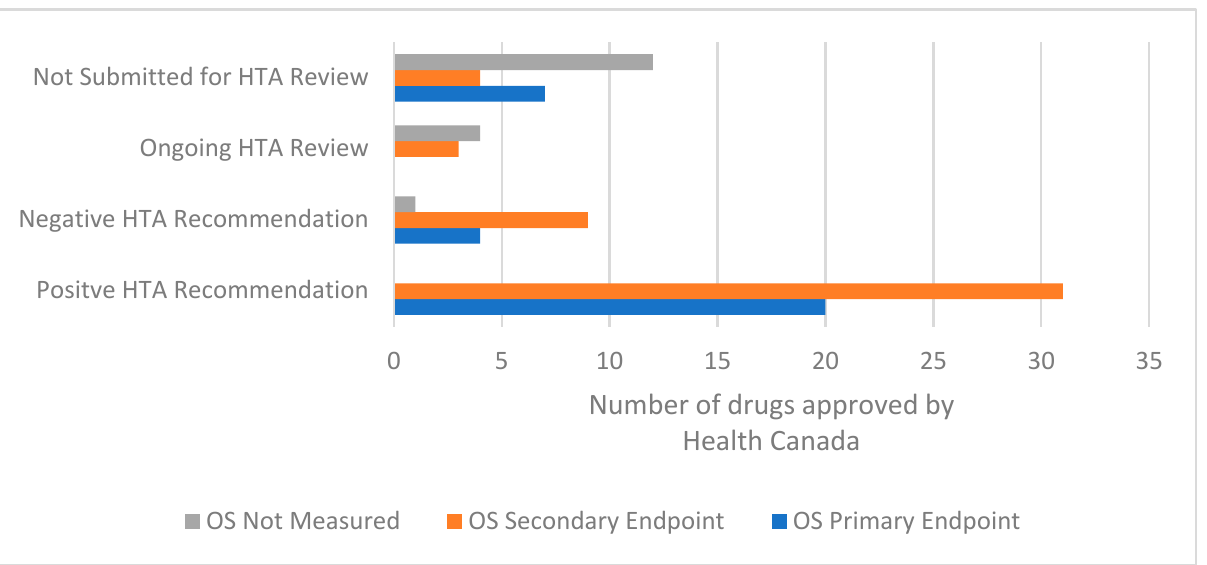
Figure 5. Comparison of overall survival as an endpoint and CADTH recommendation or status for drugs for solid tumour indications approved by Health Canada from 1 January 2017 to 31 October 2021. Abbreviations: HTA, health technology assessment; OS, overall survival.